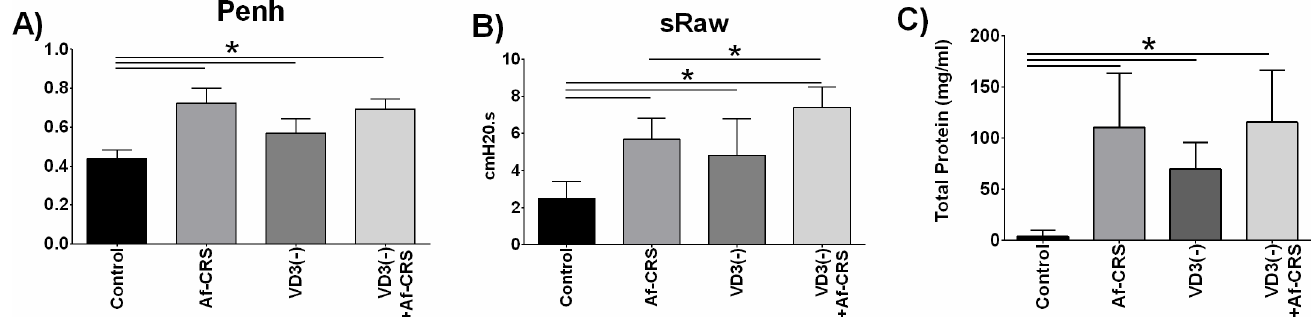
Fig 2. VD3 deficiency alone worsens airway function and injury similar to Af-CRS. (A) Penh and (B) sRaw were measuredby dual-chamber whole-body restrainedplethysmography24 hours after the last Af i.n. instillation.( C ) Nasal lavagetotal protein was measuredas an indicatorof upper airway damage. * p < 0.01vs control. # p < 0.05vs Af-CRS. n = 5–6 mice/group.